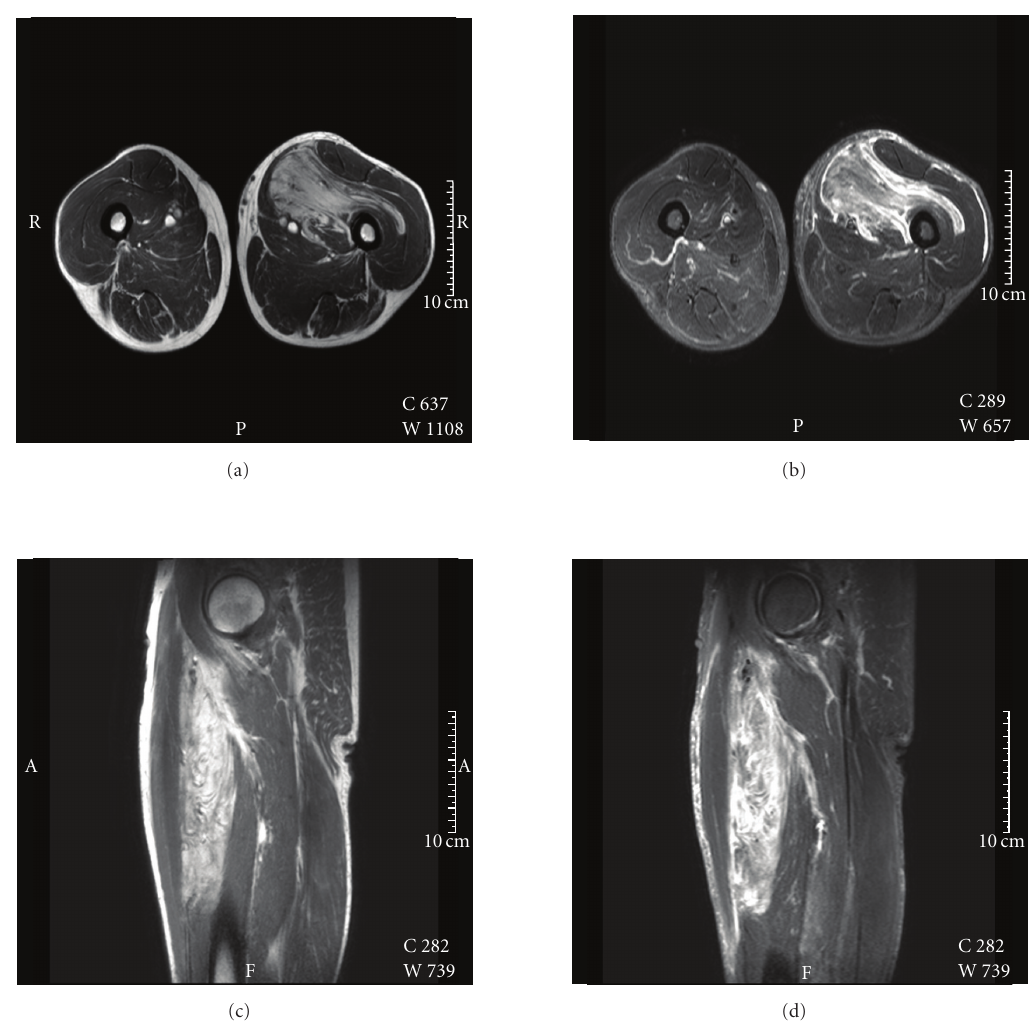
Figure 1: Upper left transversal T1 (TR 545 TE 20) and fat saturated STIR image (TR 12000 TI 200 TE60) upper right, showing the thigh and a homogenous lobulated mass. Coronal T1 and T2 weighted image is shown at the lower part of Figure 1, an image through left thigh showing a homogenous mass with irregular